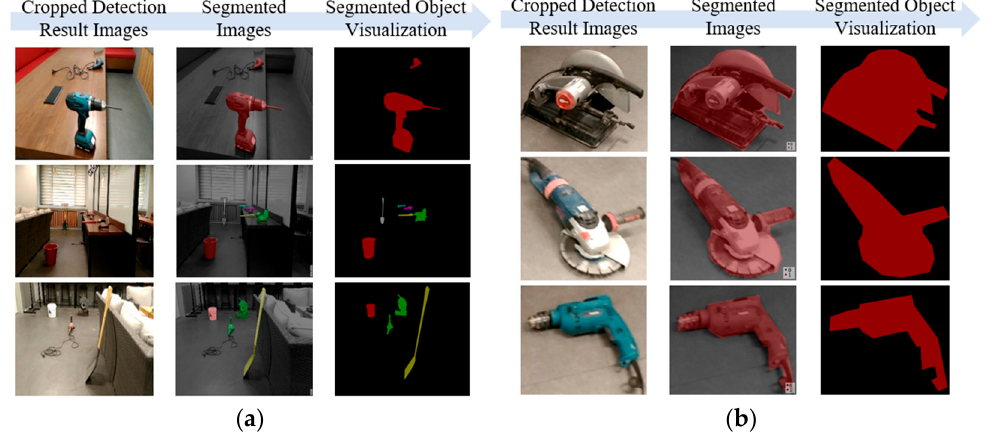
Figure 12. Visualization example of segmented images by ‘Labelme’, ( a ) models of small and medium-sized construction tools, ( b ) simulated indoor construction environment.